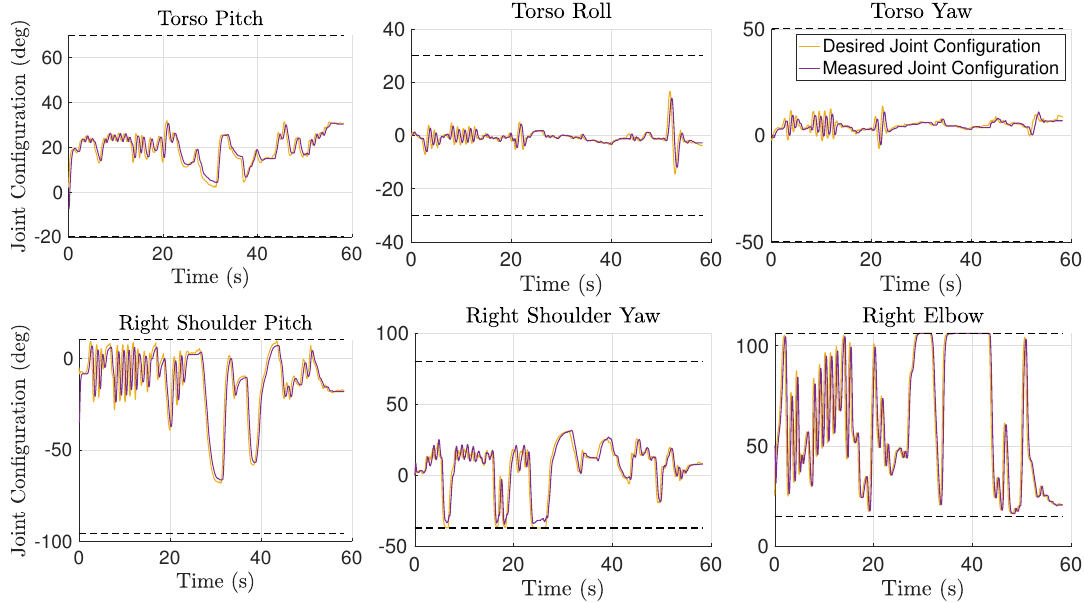
Figure 9. Joint configuration of the iCub model obtained from human motion data using dynamical inverse kinematics. The plots show both the desired joint configuration computed by inverse kinematics, and the joint configuration measured from the robot. Dashed lines represent the joint